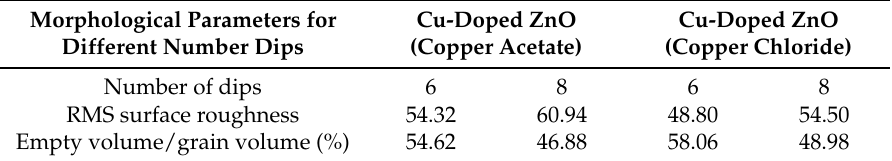
Table 3. RMS surface roughness and ratio of empty volume/grain volume of Cu-doped ZnO thin films prepared from copper chloride and copper acetate by 6 and 8